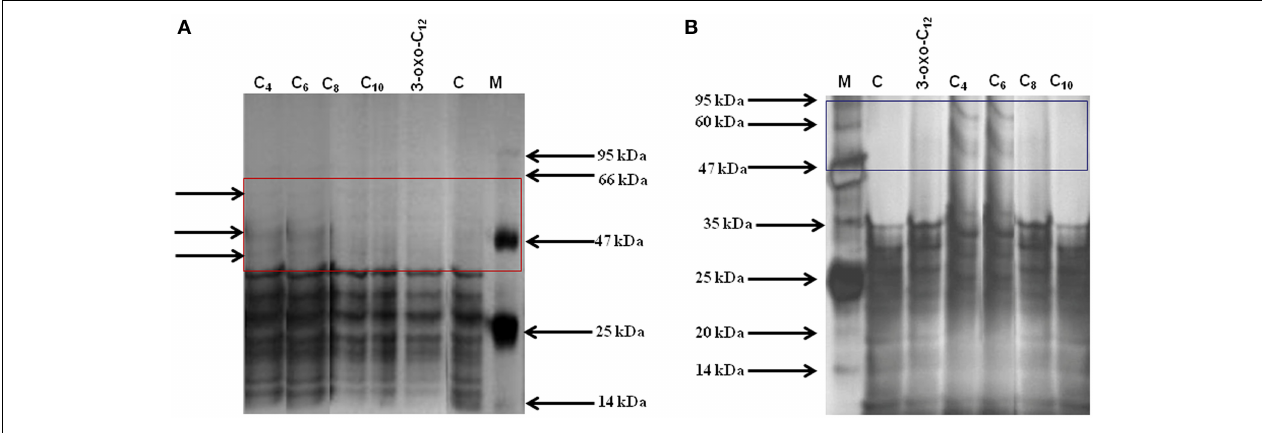
FIGURE 6 | Total protein profiling of AHLs treated cystocarps and cystocarp bearing plantlets of G. dura with polyacrylamide gel electrophoresis . (A) SDS-PAGE analysis of AHLs treated cystocarpic